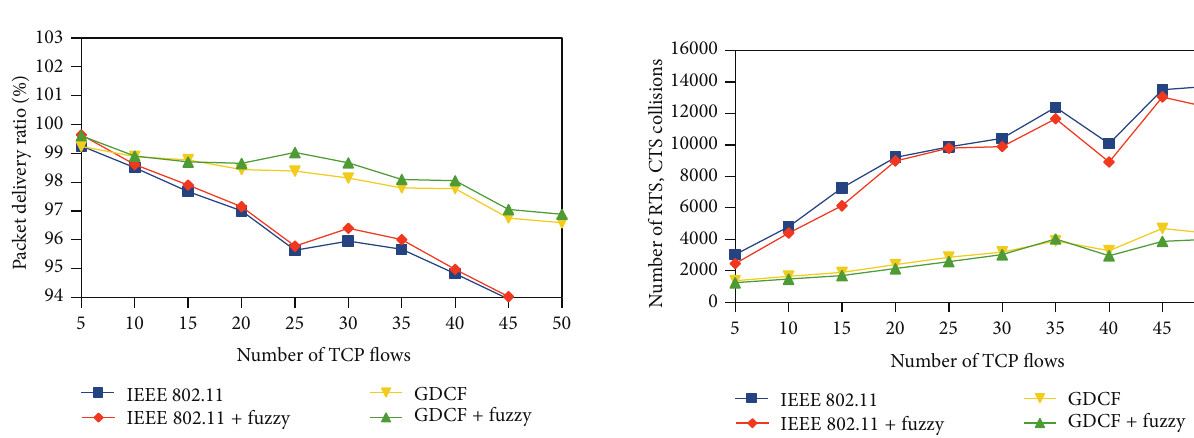
Figure 13: Packet delivery ratio for 500 ∗ 500 scenario.